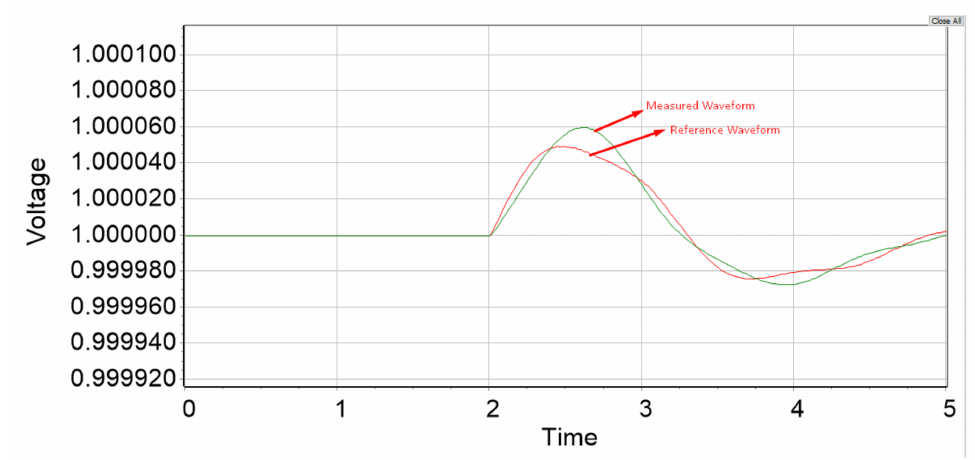
Figure 7. Operational characteristics of a voltage surge relay